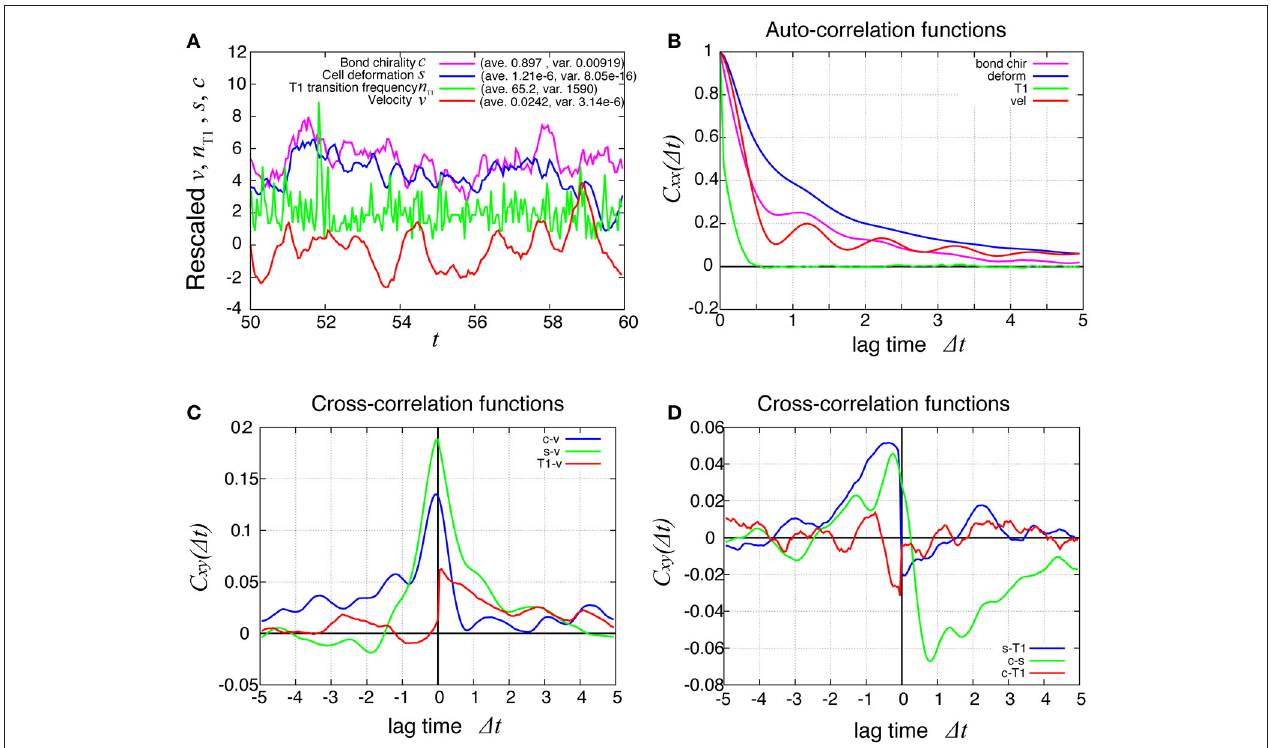
FIGURE 8 | Dynamics and correlation functions for K p 7.5 in the presence of line tension fluctuation, showing a weak oscillation in cell motility and the correlations = with other quantities. (A) Time evolutions of the average angular velocity (red curve), the number of T1 transitions per unit time (green curve), the average s (blue v , n T1 , s , c plotted in this figure were rescaled as ( x curve), and the bond chirality c (purple curve) in the time window from t = 50 to 60. The quantities x = x respectively, with the average and standard deviation σ x . The plots are offset by 2 ( n T1 ), 4 ( s ), and 6 ( c ), for visibility. (B) Auto-correlations of v , n T1 , s , and c . (C) h i δ x ( t ) δ v ( t 1 t ) /σ x σ v , where x is n T1 , s , or c (red, green, and blue, respectively). Cross-correlation functions between v and the other quantities, given by C xv ( 1 t ) = h + i x x Here, the positive time difference 1 t means that x precedes v . δ x . (D) Cross-correlation functions given by C sn T1 ( 1 t ) = − h i C cs ( 1 t ) δ c ( t ) δ s ( t 1 t ) /σ c σ s , and C cn T1 ( 1 t ) δ c ( t ) δ n T1 ( t 1 t ) /σ c σ n T1 = h + i = h + i